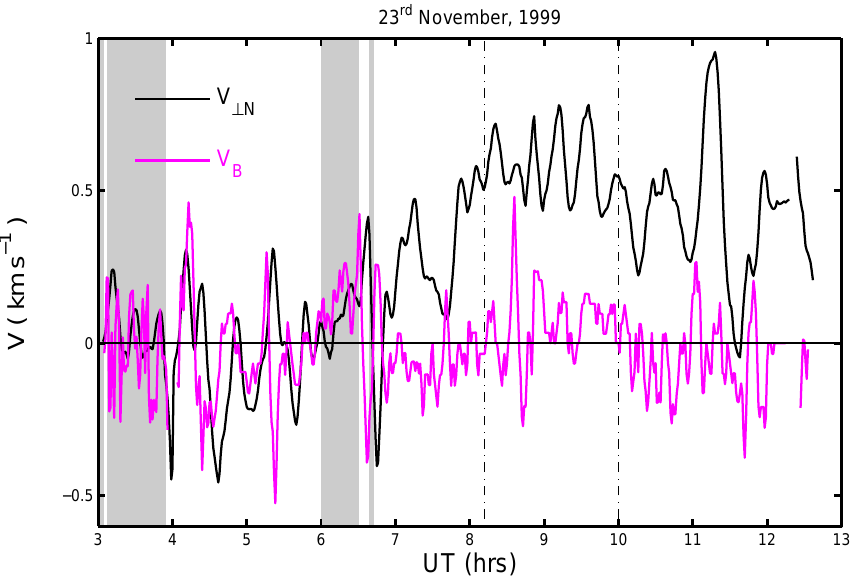
Fig. 12. (Black) Variations of the boundary normal convection velocity V ⊥ N derived by combining V 1 and V 2 for the range gates im- mediately poleward of the open-closed boundary signature. (Mauve) the velocity of the boundary motion V B . Both velocities are in the field-perpendicular direction and both are positive poleward. Data are 5-point running means of 1-min data. As in Fig. 3, areas shaded grey are northward IMF and the vertical dot-dashed lines mark the expansion/recovery phases of the larger